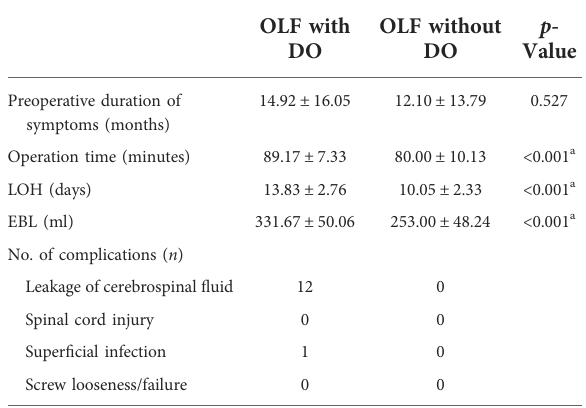
TABLE 2 Clinical characteristics.